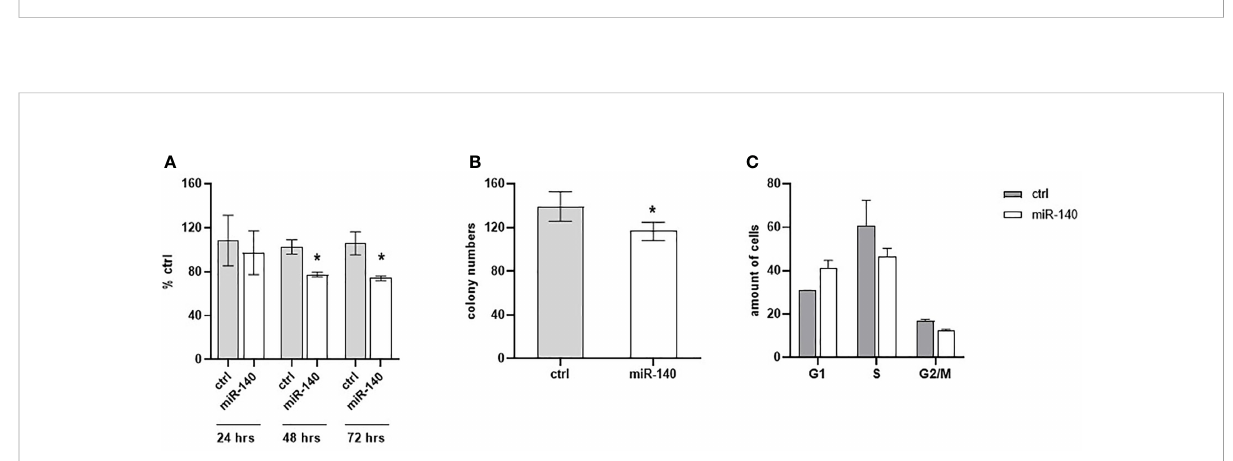
FIGURE 6 MiR-140 enhances the oxaliplatin sensitivity of CRC cells. (A) CRC cell proliferation after miR-140 and oxaliplatin treatment is decreased after 48 h (p < 0.05) and 72 h (p < 0.05). (B) Analysis of cell clonogenicity potential showed a signi fi cant decrease in CFA (p < 0.05). (C) Analysis of cell cycles showed an accumulation of cells in the G1 phase and a decrease in the S phase. The results represent the mean value of three independent experiments ± SD. *p ≤ 0.05. CRC, colorectal cancer; CFA, clonogenicity formation